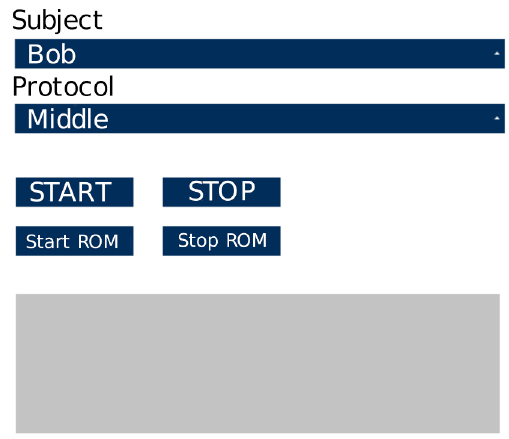
Figure 4. Track-Task control